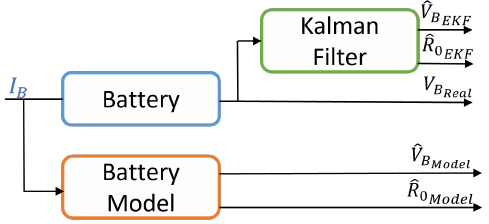
Figure 6. Integration among data, reference model and EKF. The voltage error is calculated between the real voltage and the filter estimated one. The value is normalized by the nominal voltage of each cell, as in (19), (21) and (23), due to the small error value on RMSE and ME, the value are expressed in parts per million(ppm). The error is calculated as a comparison between the value estimated by the EKF and the true value of the model presented in Section 2. This value is normalized by the resistance value at SOC = 50%, as in (20), (22) and (24), where there is a plateau of the resistance value. This choice allows us to compare the accuracy of the method with different